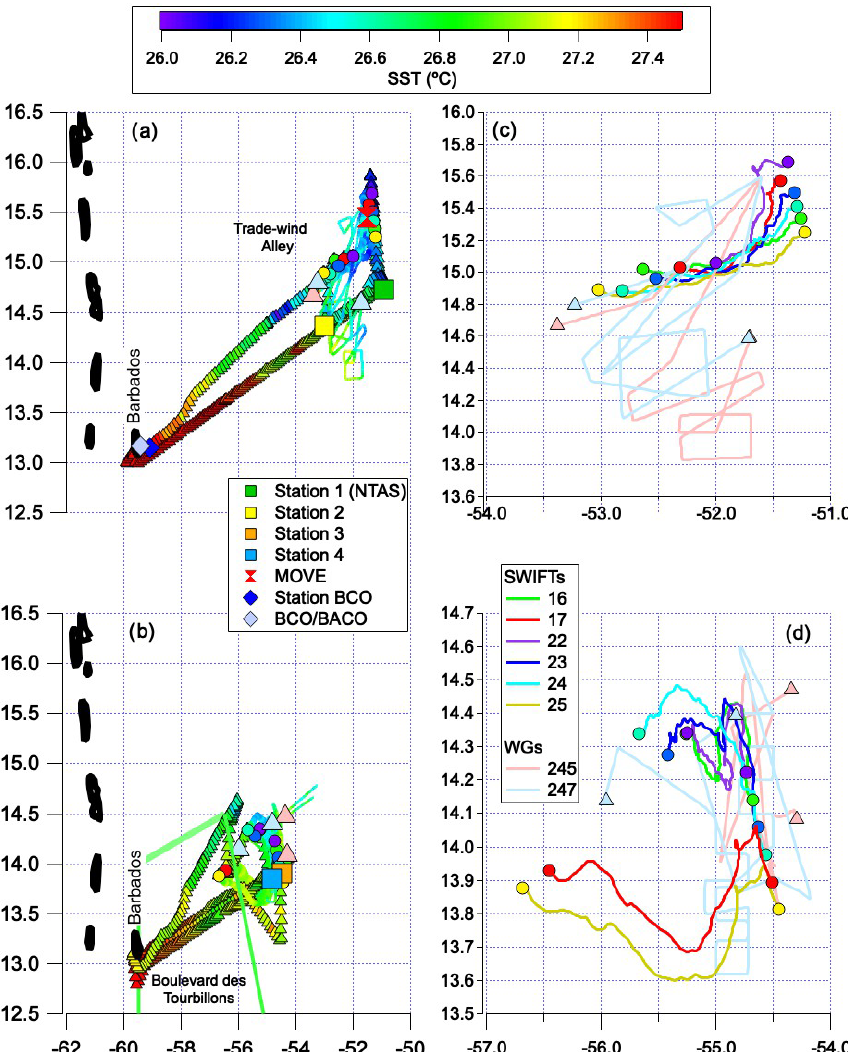
Figure 1. Tracks of the RV Ronald H. Brown , Wave Gliders, and SWIFTS during ATOMIC (colored by seawater skin T calculated by PSL) for (a) Leg 1 and (b) Leg 2. Tracks for Wave Gliders and SWIFTS are magnified in (c) Leg 1 and (d) Leg 2. The portion of the EUREC 4 A study area overlapping with ATOMIC is indicated by the solid green line in (b) . Locations of RV Ronald H. Brown stations, MOVE, and BCO/BACO are also shown in (a) and (b)